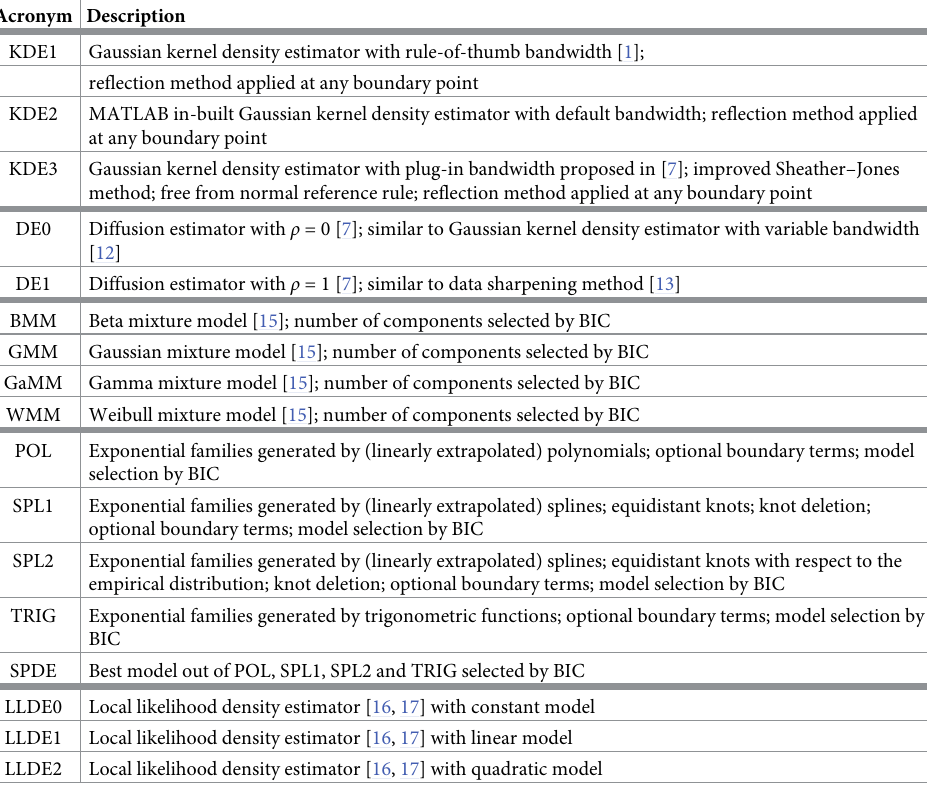
Table 2. Overview of density estimators. See S3 Appendix for